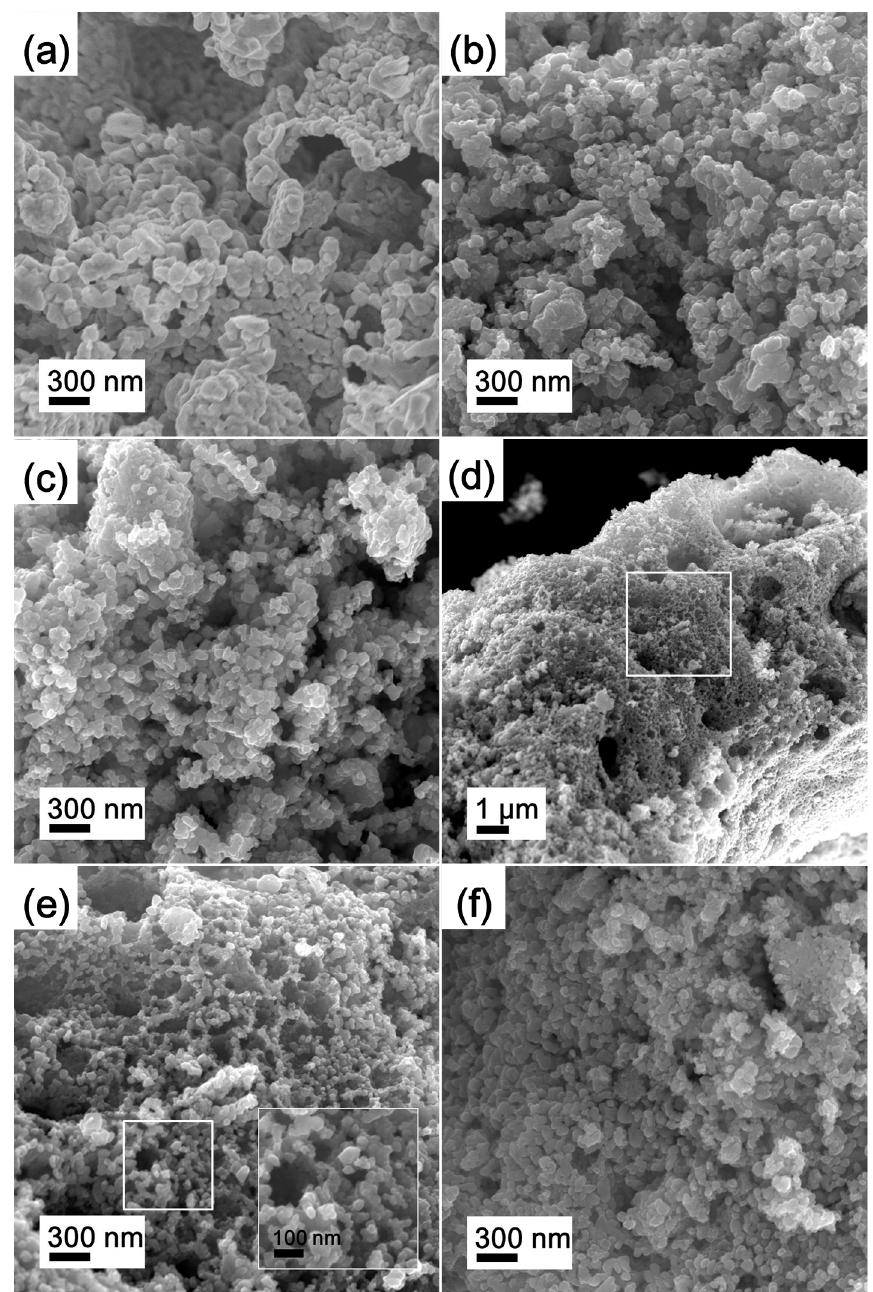
Figure 9. FE-SEM images of La 2 O 3 doped Mo nanopowders for ( a ) LM0, ( b ) LM3, ( c ) LM6, ( d , e ) LM9, and ( f ) LM12 reduced by the Ar calcination–H 2 reduction process.